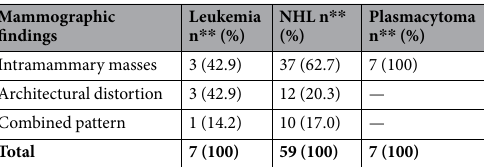
Table 4. Mammographic patterns in different intramammary hematological malignancies (IHM). Notes: * There were no significant differences in patterns between the IHM groups; P > 0.05. ** n = number of patients.